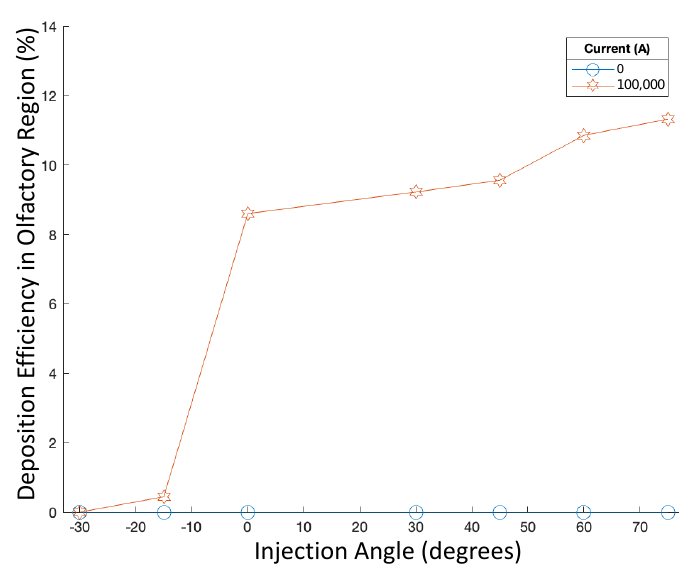
Figure 13. Deposition efficiency in varying magnetic fields for varying injection angles for targeted